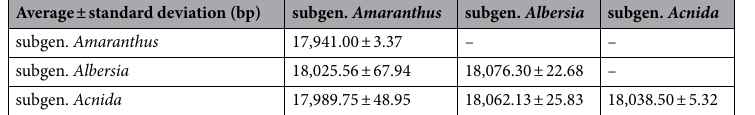
Average ± standard deviation